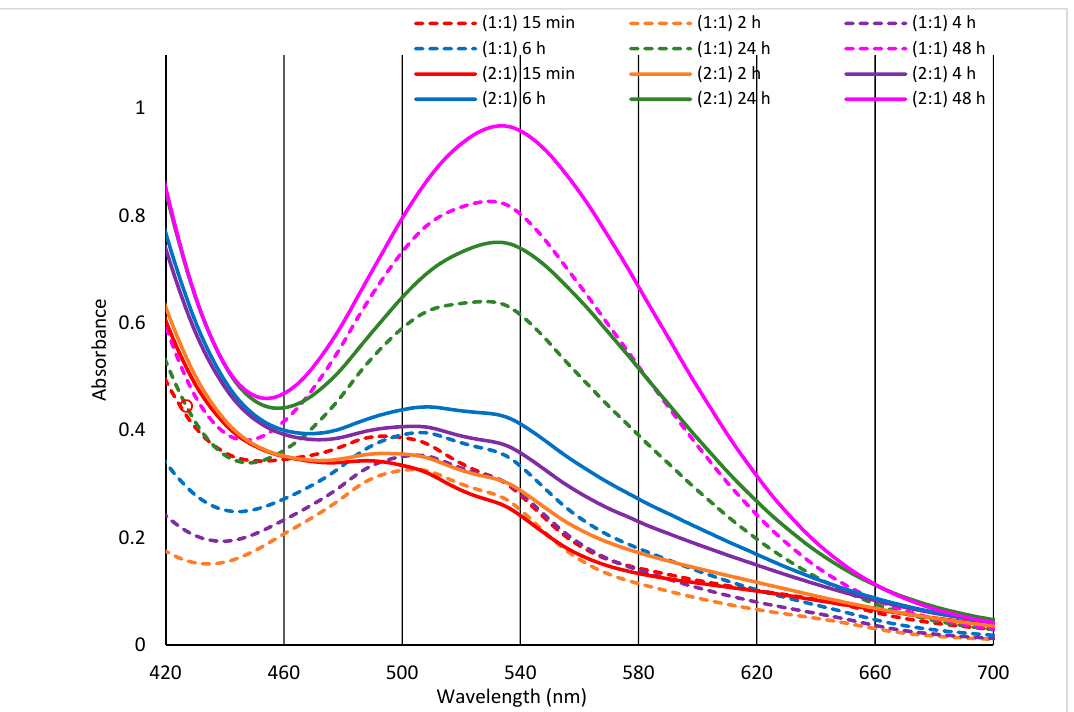
Figure 5. Timing structure development of Arginine-Co(II) complex starting from mixing the components; solid curves represent mixture solution in molar ratio Arginine to Co(II) = 2:1 and dashed ones 1:1, respectively.